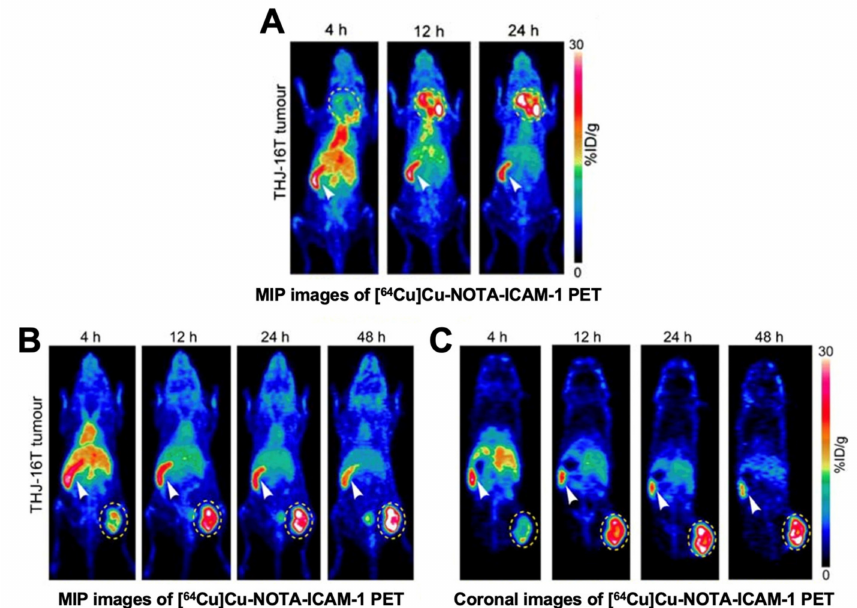
Figure 9. [ 64 Cu]Cu-NOTA-ICAM-1 immunoPET imaging in ATC xenografts (cell line: THJ-16T). ( A ) Maximum intensity projection (MIP) images in an orthotopic model. ( B ) MIP images in a subcutaneous model. ( C ) Coronal images of the same model. Reproduced with permission from [101], copyright 2020 Springer Nature Inc.